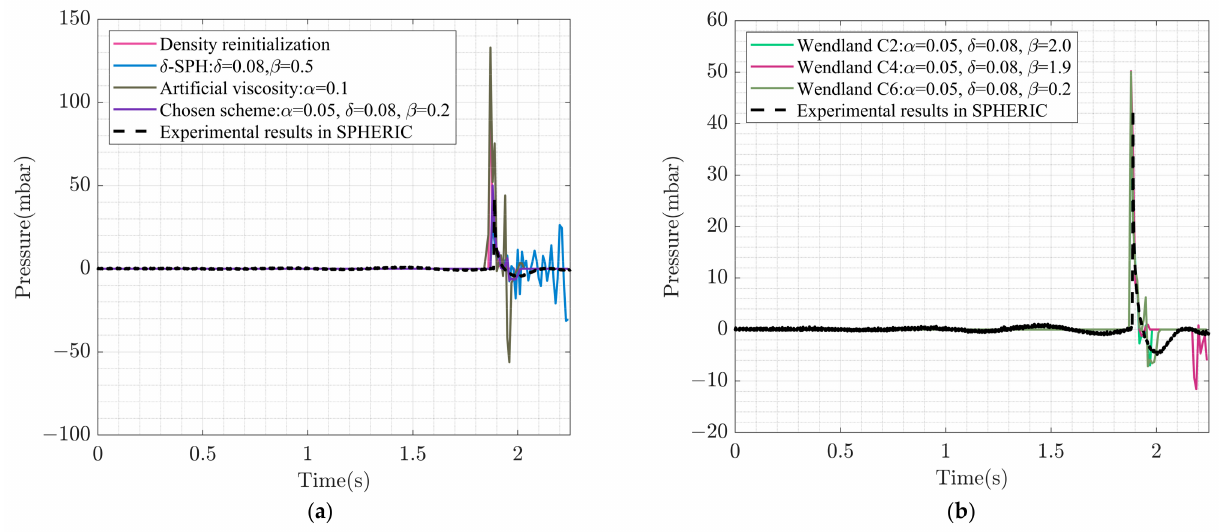
Figure 10. ( a ) Comparison of the interpolated pressure data at the measurement location with the experimental measure- ments for different numerical dissipation schemes using WC6 kernel. ( b ) Comparison of the interpolated pressure data using the chosen numerical scheme for different Wendland